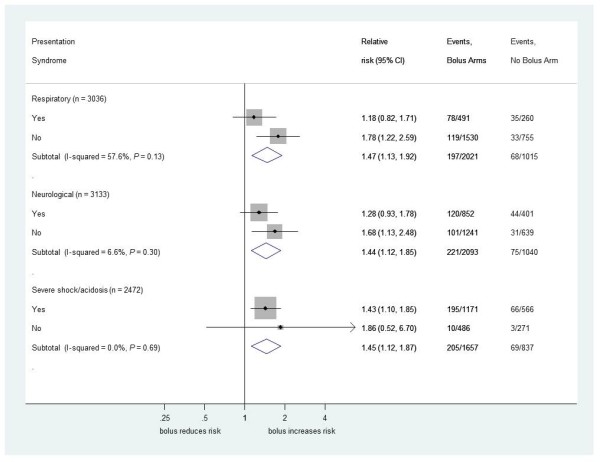
Mortality risk at 48 hours for bolus compared to no bolus by presentation syndromes at baseline. Forest plots comparing effect of bolus versus no bolus for each baseline presentation syndrome (respiratory, neurological or severe shock or acidosis); children could be assigned to more than one syndrome.